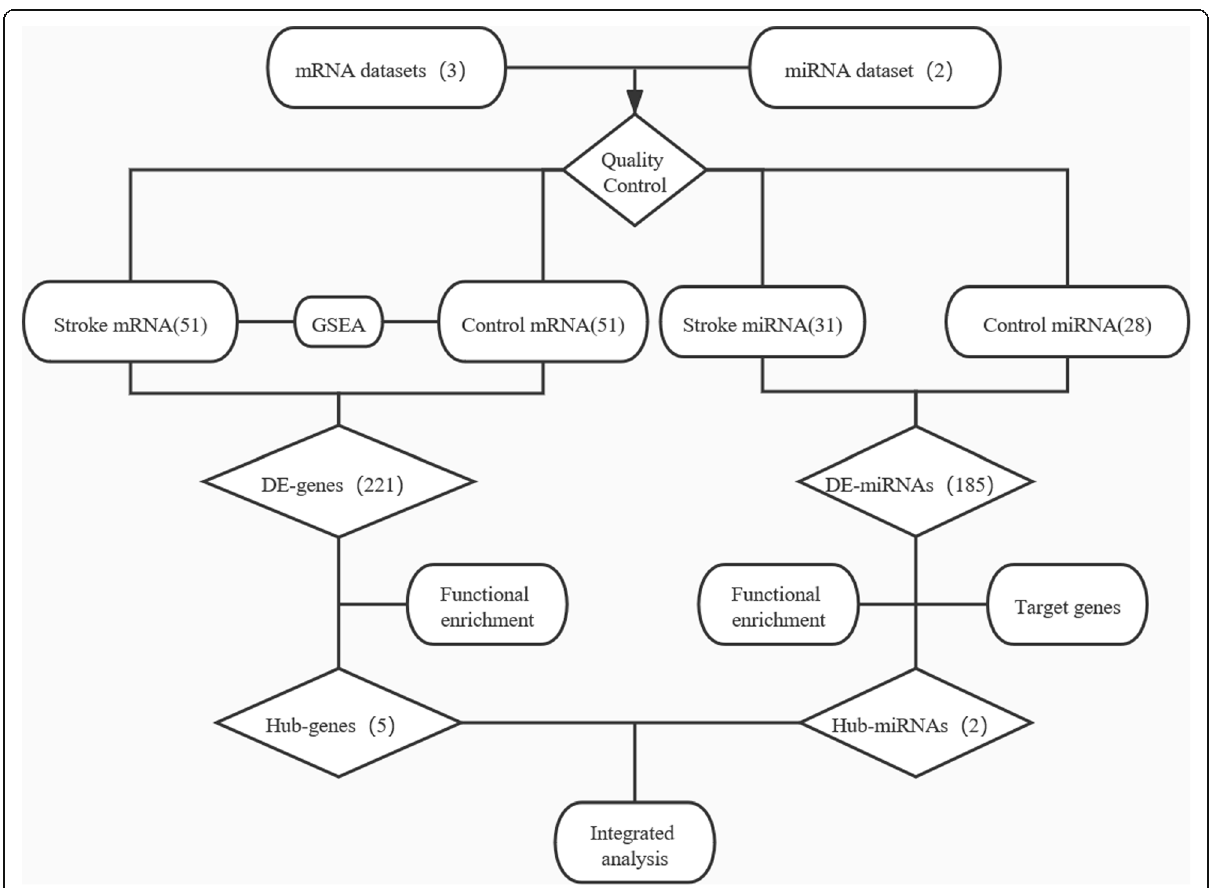
Fig. 1 Flowchart illustrating the bioinformatic analysis